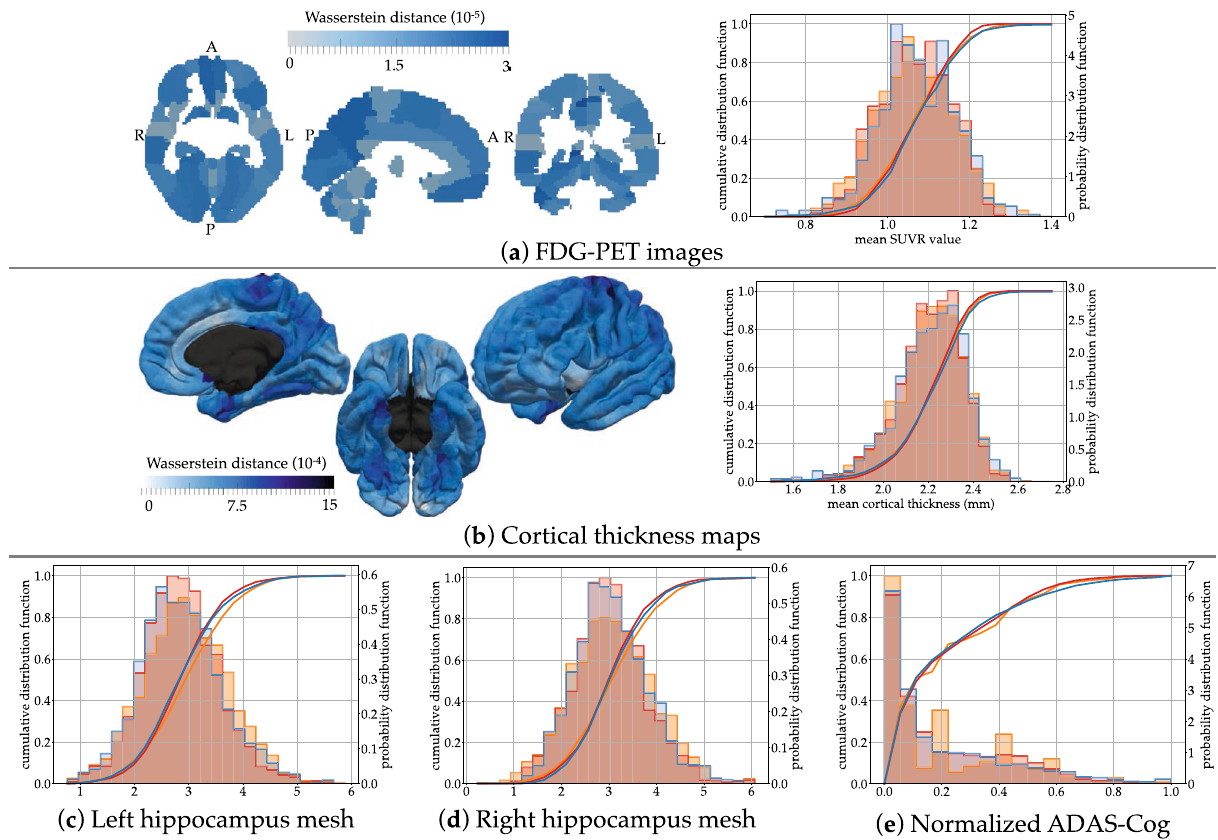
Figure 5. Statistics of the virtual cohort. Superimposition of empirical distributions for simulated data (blue), reconstructed errors (red, as in Fig. 3) and real data (orange). Images were obtained using the freely available software FSLeyes v.0.22.6 (https:// fsl. fmrib. ox. ac. uk/ fsl/ fslwi ki/ FSLey es) and Paraview v.5.2.0 (www. parav iew.